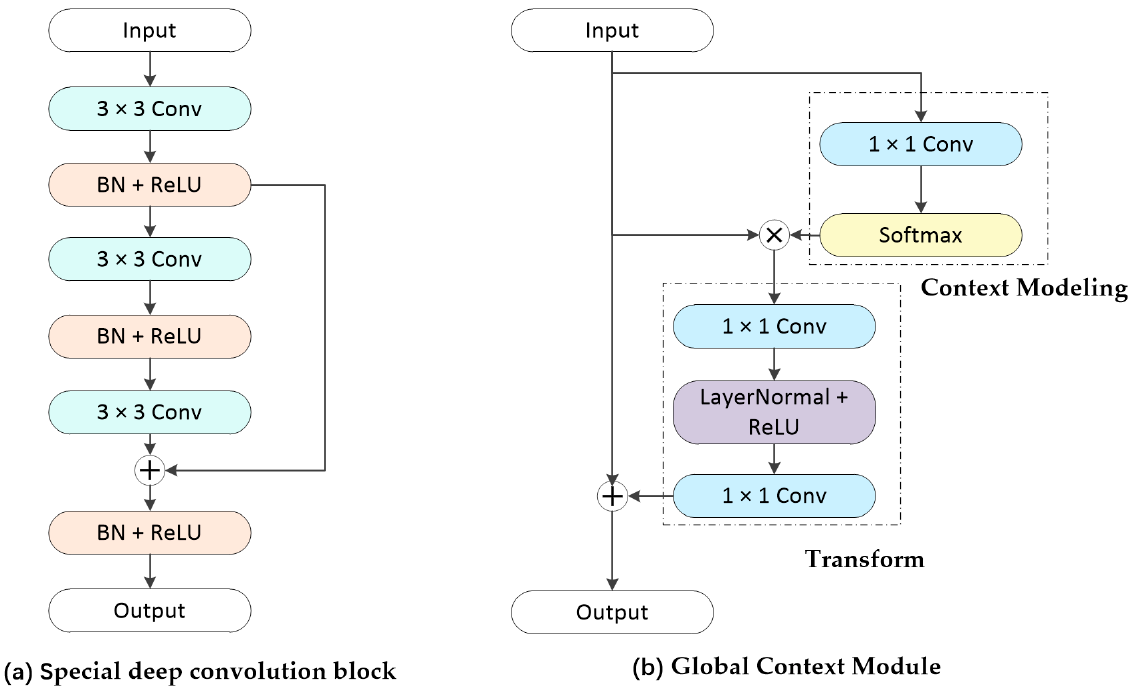
Figure 5. Architecture of the special deep convolution block and Global Context Module in Dual-Path. ⨁ denotes broadcast element-wise addition and ⨂ denotes matrix multiplication .